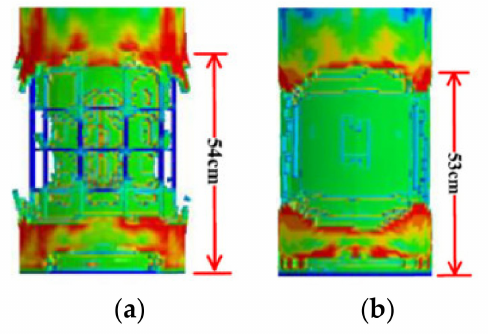
Figure 23. Column damages after detonation of 1kg TNT: ( a ) RC and ( b ) RC + CFRP column [69]. Copyright permission obtained from